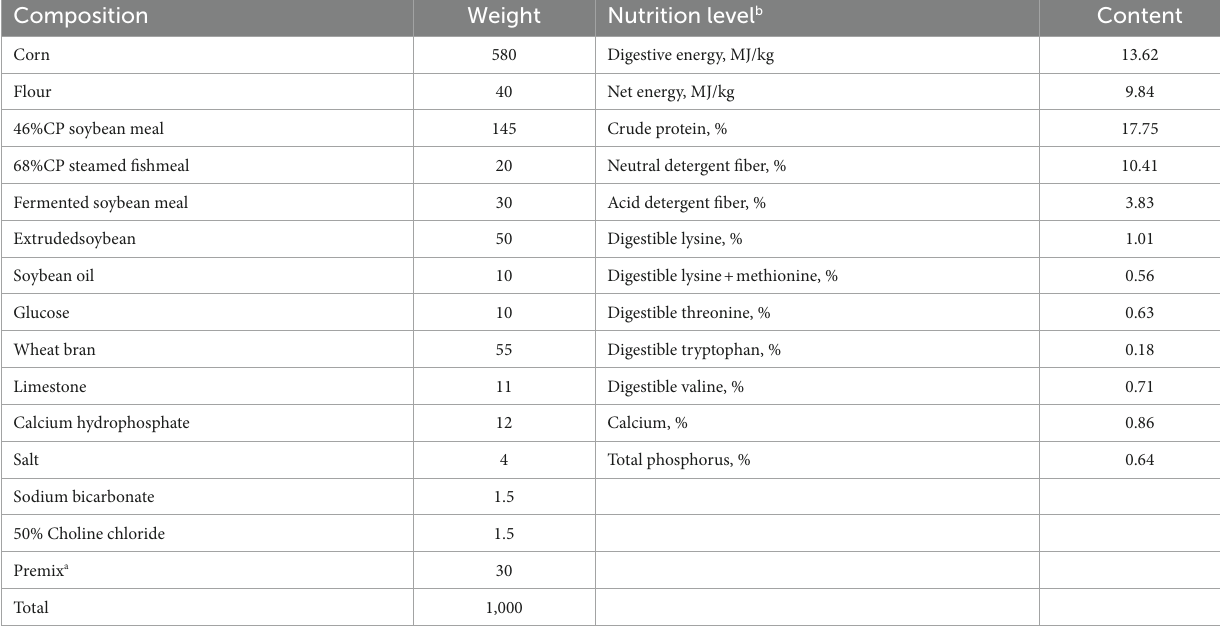
TABLE 1 Composition and nutrition level of the basal diet